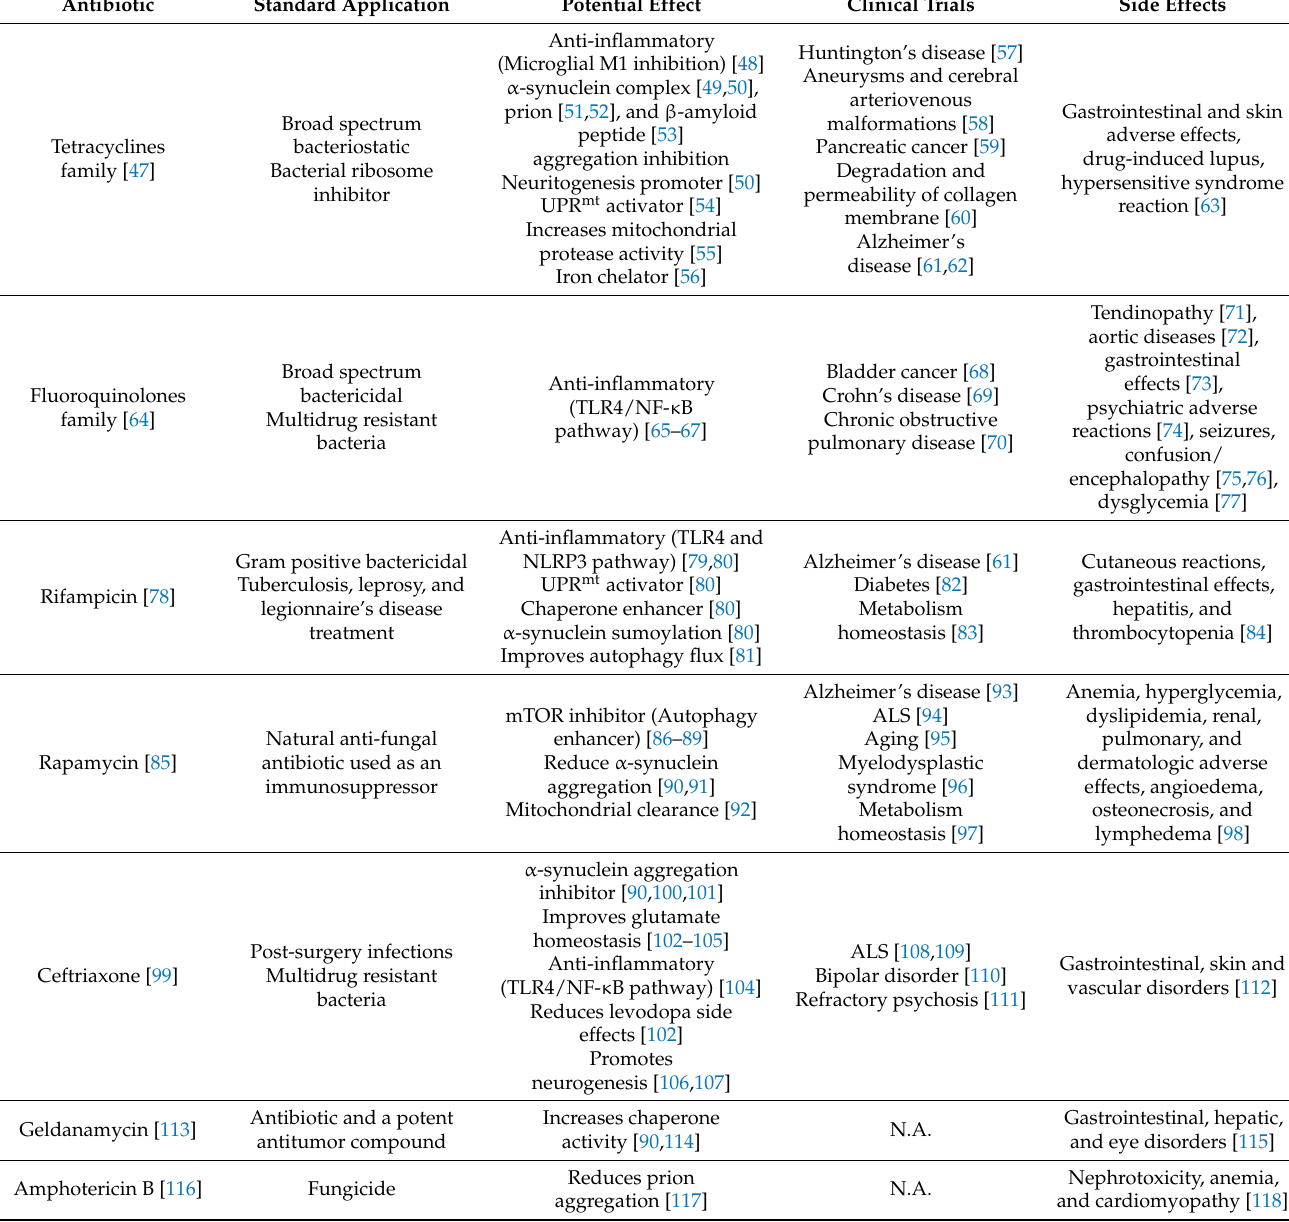
Table 1. Antibiotics and their alternative therapeutic